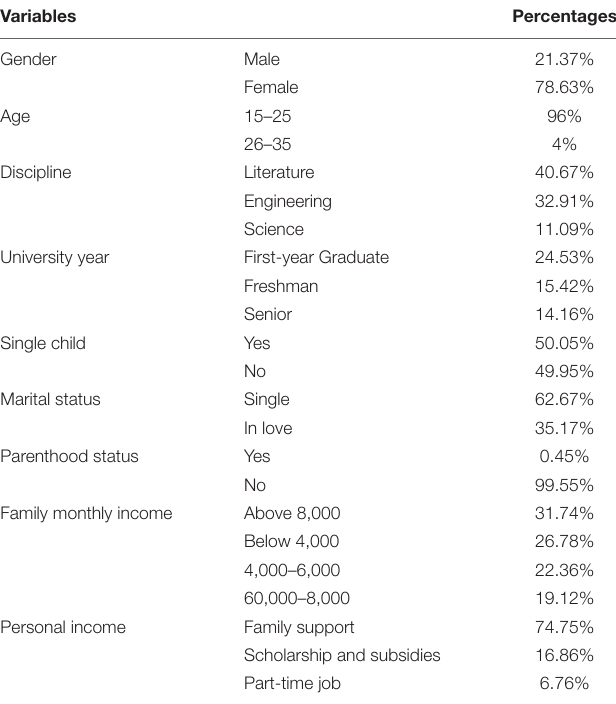
TABLE 1 | Social demographic features of participants ( N =